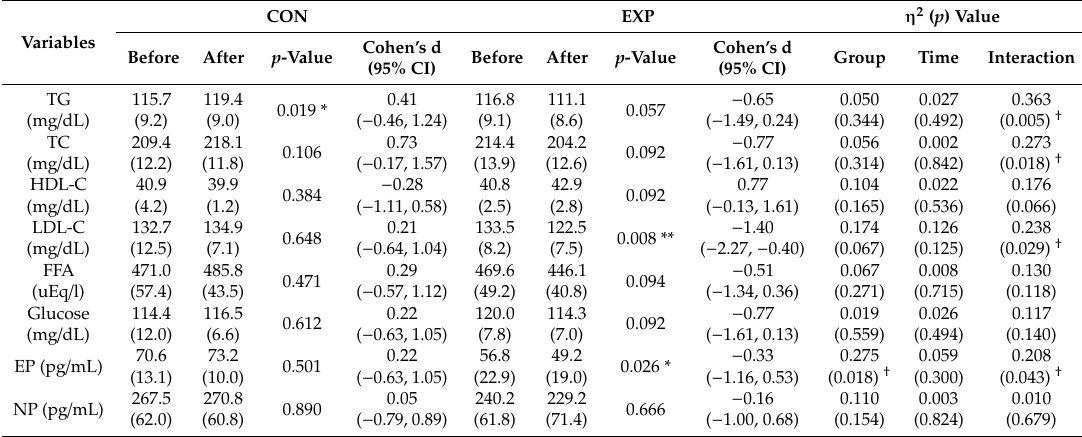
Table 4. Changes in metabolic parameters before and after 12-week intervention.